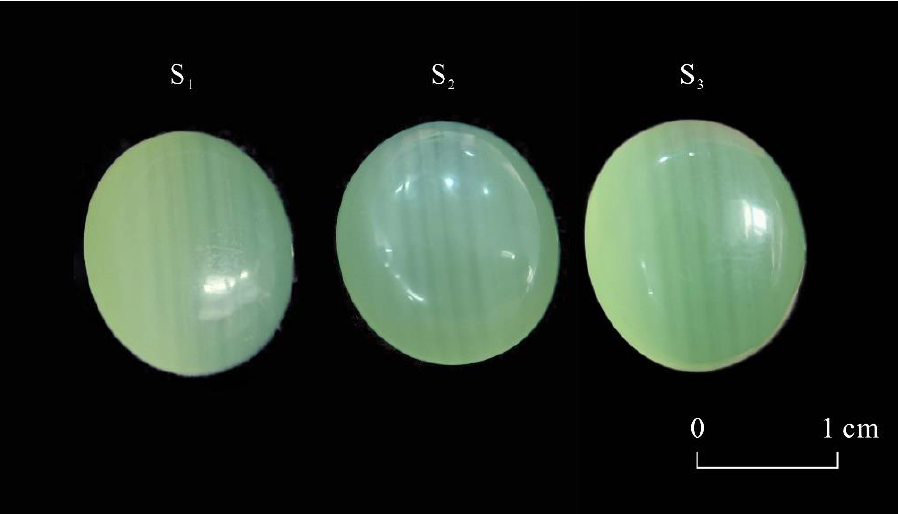
Figure 1. Cabochon specimens (S1, S2, and S3) of yellow-green Lvwen stone. All are top views. After a cabochon specimen (S 1 ) was cut into a rectangular prism, it was found that the white bands could still be observed (Figure 2). These white bands are regularly distributed, possibly caused by the lack of chromogenic elements, indicating that the banded structure is not produced by the cat’s-eye effect (i.e., chatoyancy, which is due to either a fibrous mineral structure or fibrous inclusions in a mineral). When observed at a low magnification (50 × ), the green matrix was determined to be microcrystalline, composed of only faintly visible small crystals, whereas the white bands are composed of relatively coarser crystals (~100 µ m). The parallel needle-like crystals of the latter are oriented perpendicular to the band planes (Figure